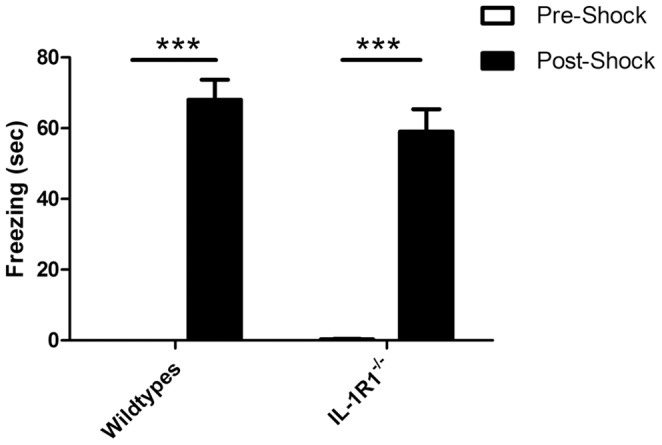
Performance of IL-1R1−/− mice versus WT in the contextual fear conditioning paradigm.The time spent freezing measured across 2 minutes (pre-shock) and 5 minutes, 48 hours later (post shock), following foot shock at 0.4 mA for 2 seconds for IL-1R1−/− mice (n = 10) and WT mice (n = 10) in the fear conditioning paradigm. Data are expressed as mean±SEM and were analysed by t-test, bars representing pre-shock freezing are insufficiently large to be clearly visible. Bonferroni post-hoc tests after a significant effect of treatment in ANOVA analysis showed that both strains showed significant differences from their pre-shock freezing (***p<0.001).